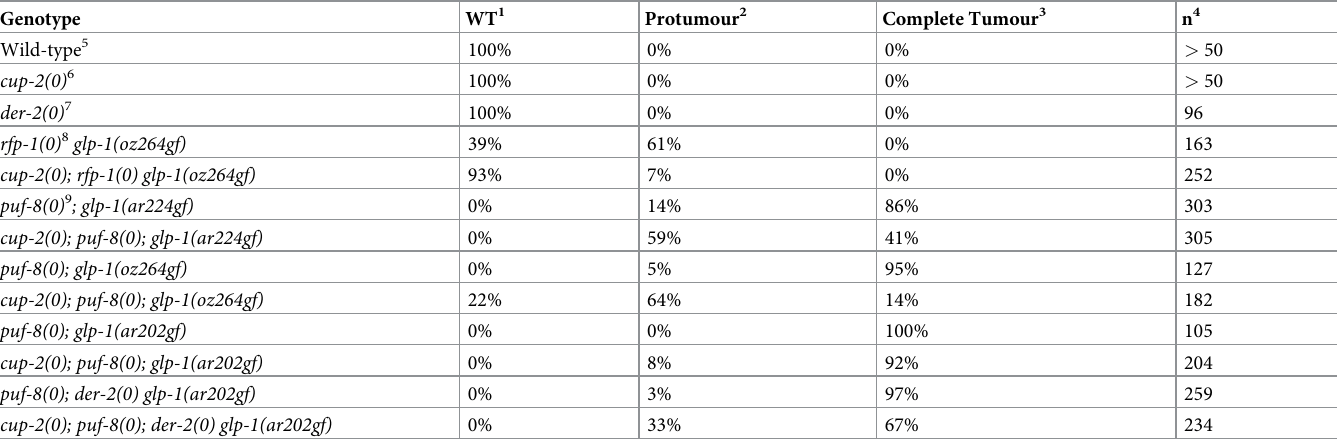
Table 1. Loss of Derlin activity supresses glp-1(gf)